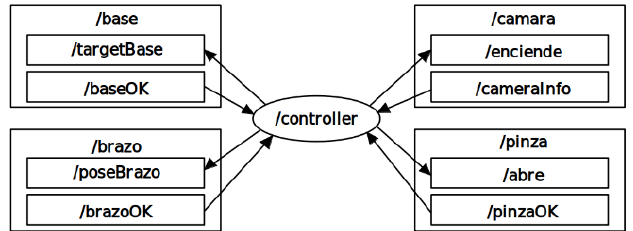
Figure 10. Structure of the controller and the four modules that define the operation of the physical assistance robot.